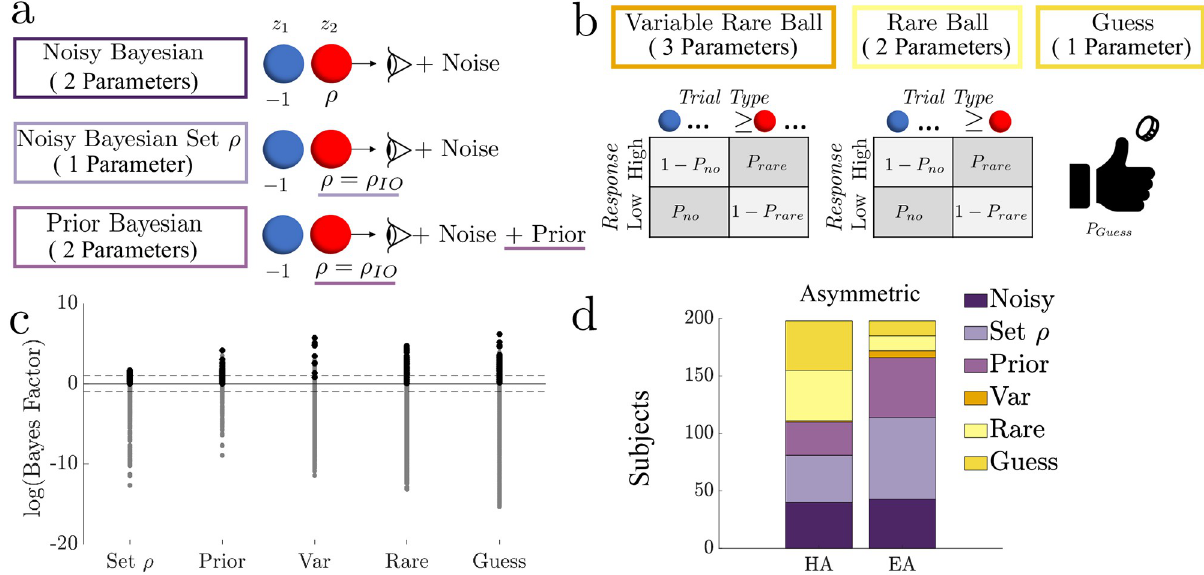
Fig 4. Subjects used Bayesian and heuristic strategies in asymmetric blocks. a. Bayesian models. Differences between the Noisy Bayesian model and alternative Bayesian models are underlined. b. Heuristic models. See Methods and ‘Formal model comparison’ section for more model details. c. Log Bayes factors (log(BF)) for each subject-block, computed between each alternative model and the Noisy Bayesian model. log(BF) > 0 favors the alternative model, with log(BF) > 1 or < − 1 (dashed lines) providing strong evidence in favor of a given model [8]. Black (grey) markers indicate that the listed alternative model is (is not) the most likely model (percentage of subjects whose most-likely model is identified by strong evidence: 36% for Noisy Bayesian, 42% for Set ρ , 32% for Prior, 90% for Variable Rare, 87% for Rare Ball, 82% for Guess). d. Subjects categorized by the model that best describes their responses for the Hard Asymmetric (HA) and Easy Asymmetric (EA) blocks. For both blocks, a majority of the subjects’ responses were best described by Bayesian models (55% in HA, 86% in EA), but with a relatively high percentage of heuristic strategies under the HA condition.